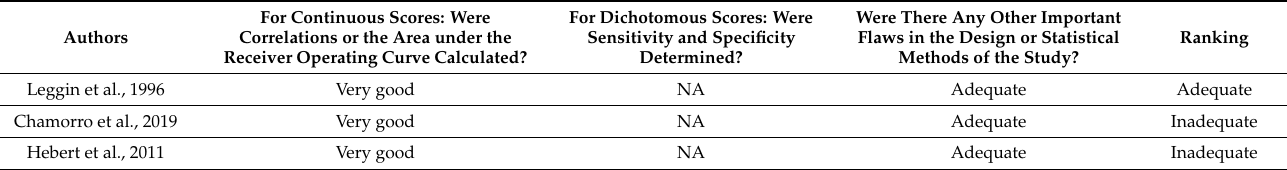
Table 6. Methodological quality considering the COSMIN checklist for studies analyzing concurrent validity between HHD and ID (box